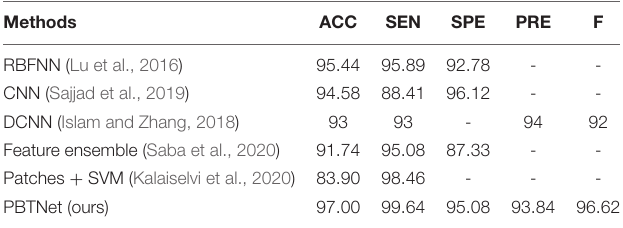
TABLE 7 | Comparison with state-of-the-art methods (unit: %). Methods